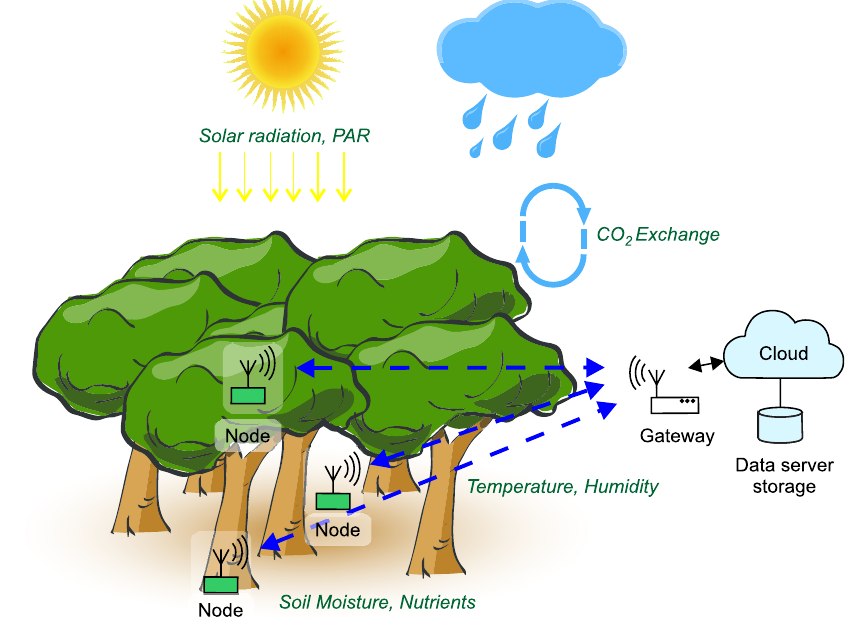
Figure 1. A monitored terrestrial ecosystem with its main processes and